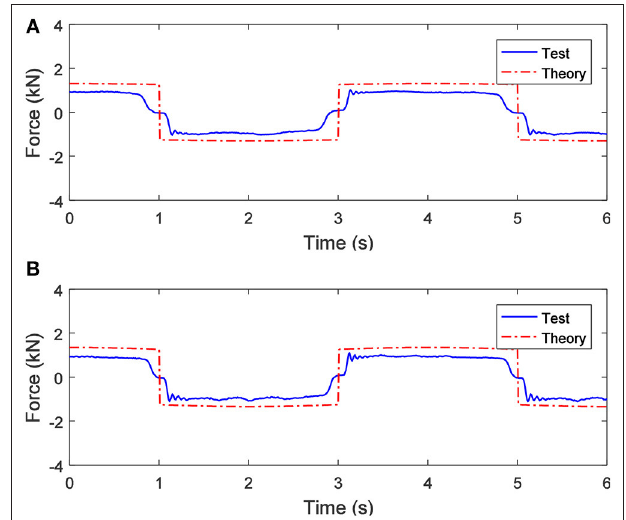
FIGURE 4 | When the applied current is 0.5A, the output force of the SAI under sinusoidal displacement excitations with a frequency of 0.25Hz and different amplitudes: (A) 10mm and (B) 20mm.